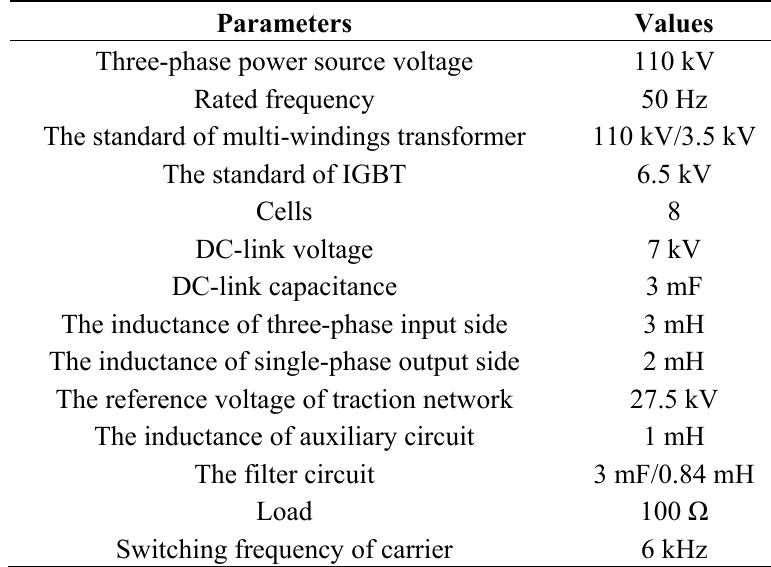
Table 1. System and control